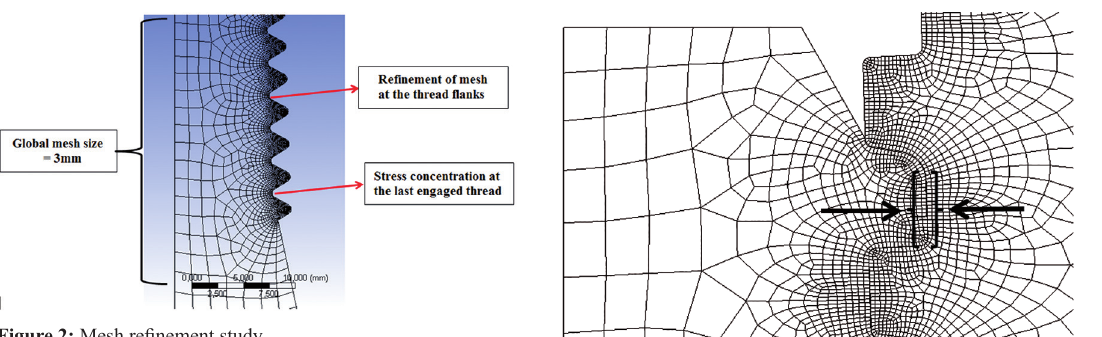
Figure 2: Mesh refinement study. Table 2: Mesh refinement study. Figure 3: Initial interference fit related to make-up torque of the